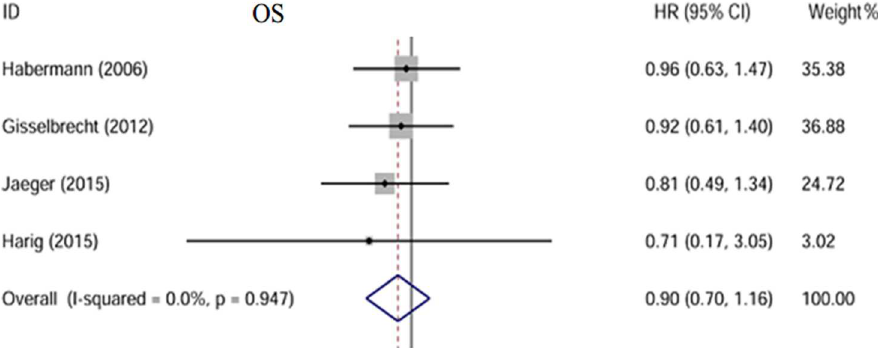
Fig 2. Forest plot of the HR. No significantdifference of OS is observedbetweentwo groups; The size of the squaresreflects each study’s relativeweight, and the diamond( ^ ) represents the aggregate HR and 95% CI.